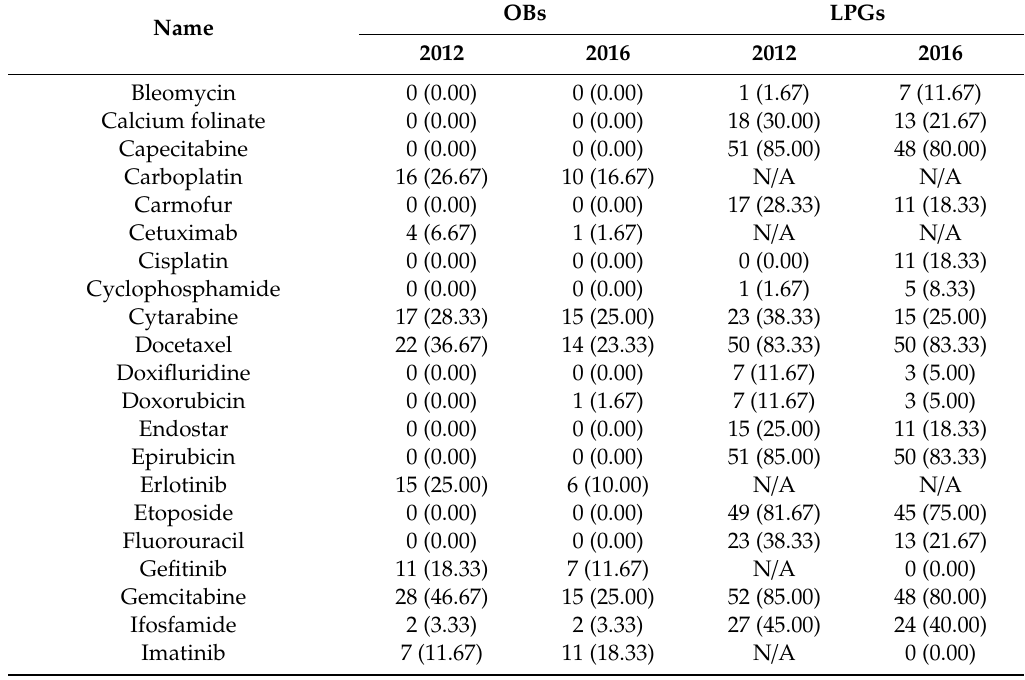
Table 3. Availability of 40 anticancer medicines in the Jiangsu Province [ n